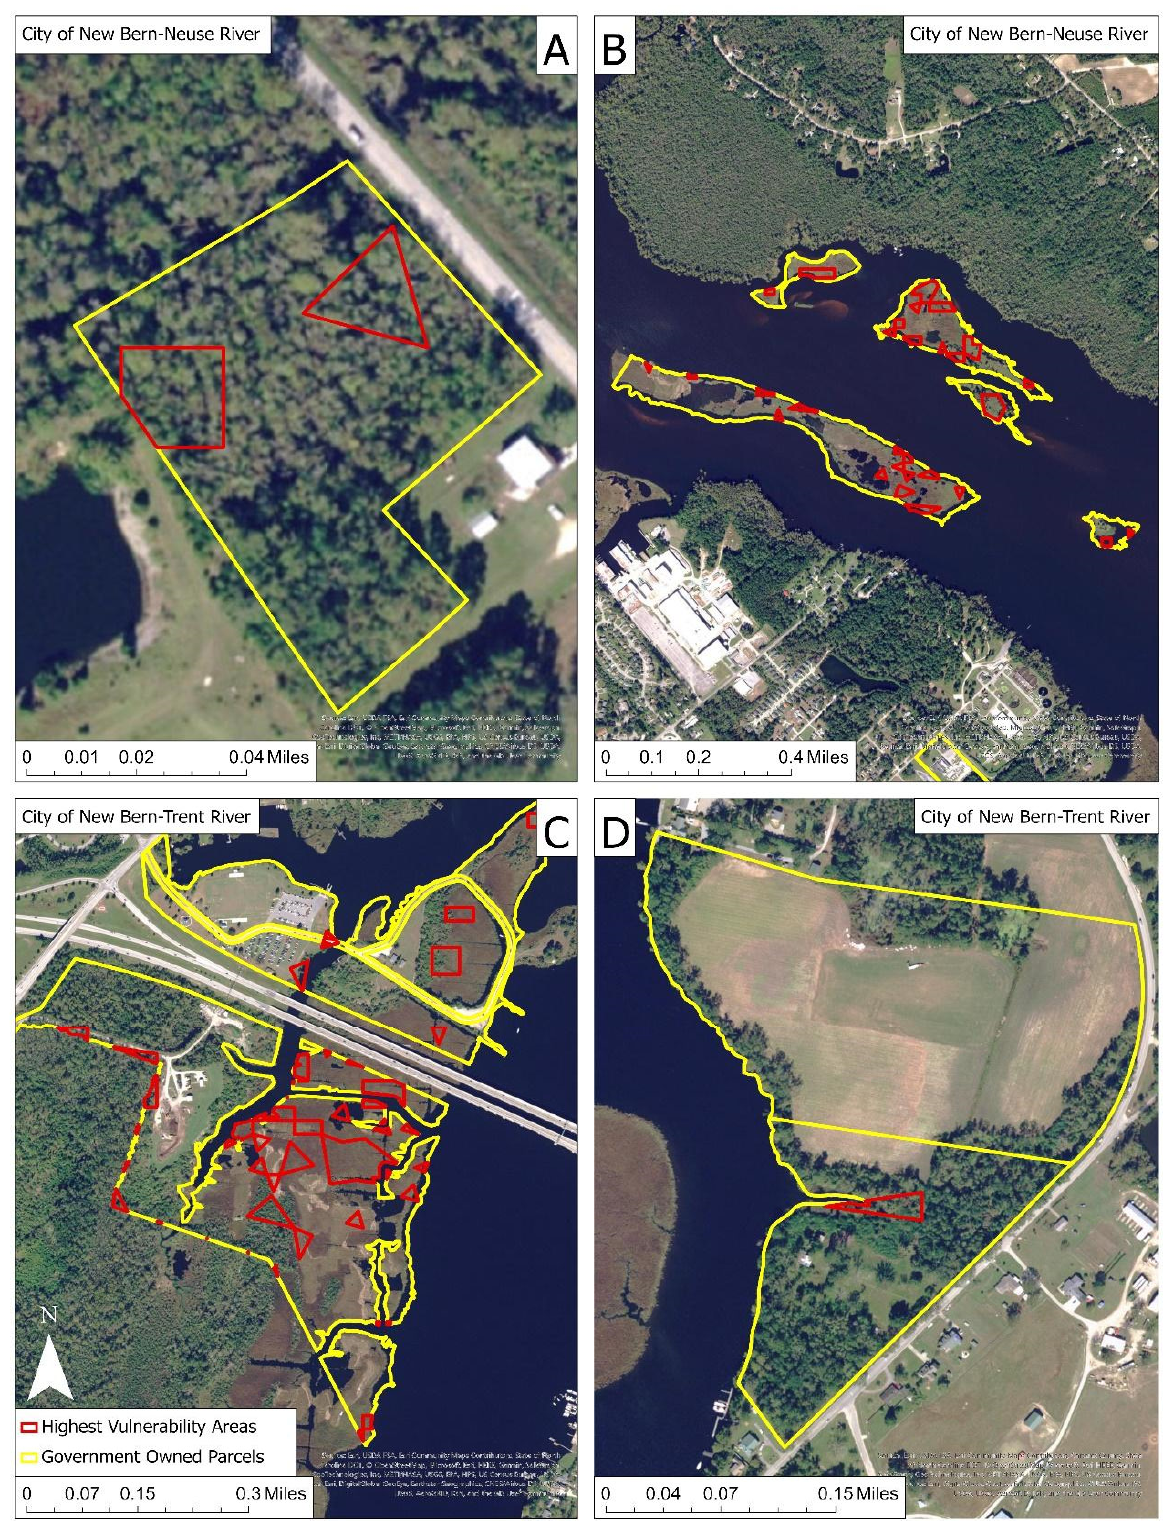
Figure 9. Overlap between the highest vulnerability areas and government-owned parcels in both New Bern study areas superimposed on NAIP imagery; ( A ) shows the Oaks Rd parcel, ( B ) shows the vulnerable islands in the Neuse River, ( C ) shows the Lawson Creek Park parcel, and ( D ) shows the Clermont parcel.